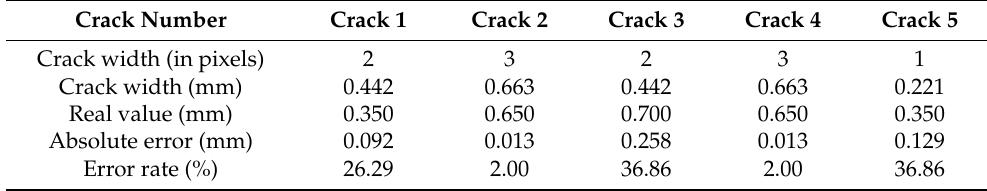
Table 9. Canny total station measurements (spatial resolution of one pixel: 0.221